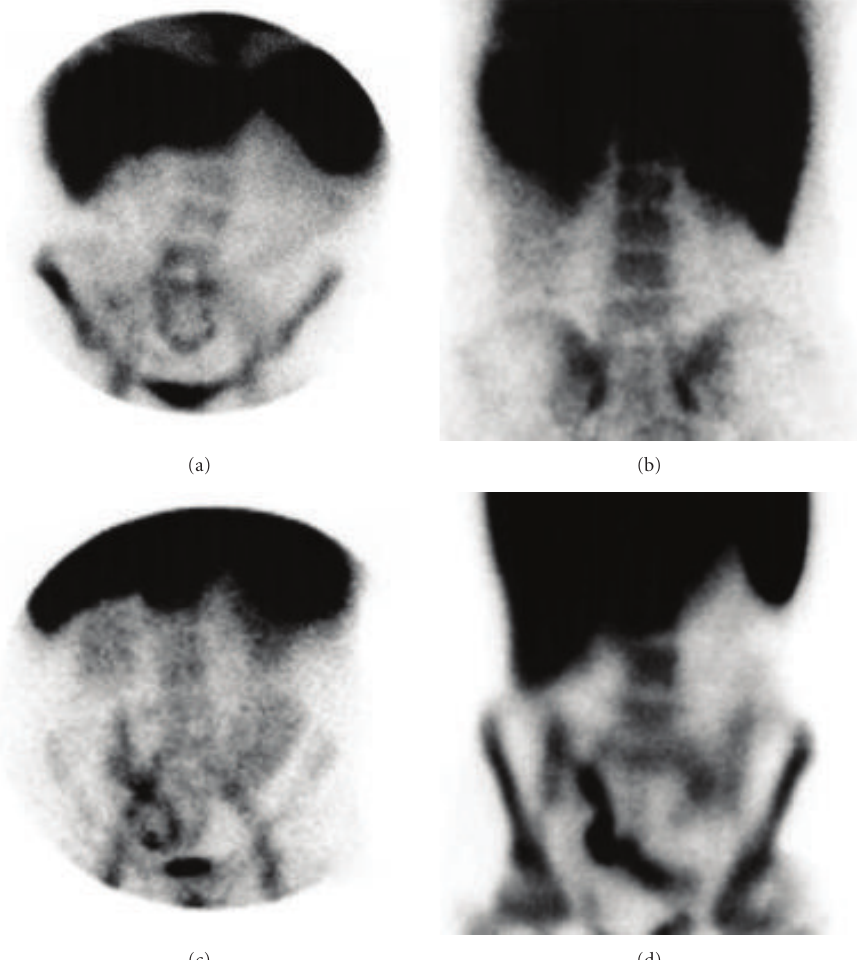
Figure 10: TLLS. (a) No inflammatory activity; (b) mild inflammatory activity; (c) moderate inflammatory activity; (d) severe inflammatory